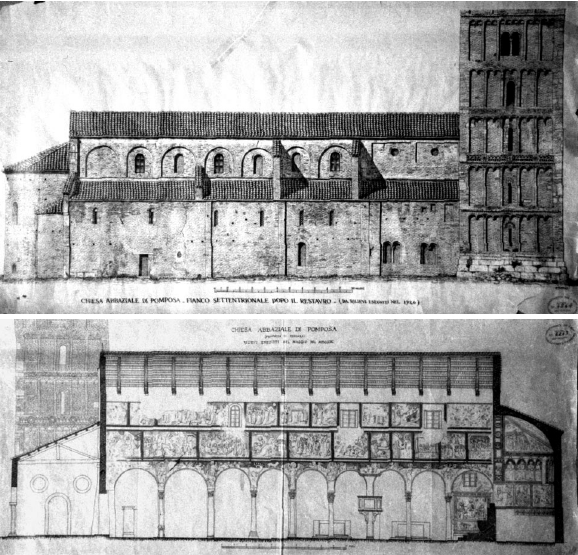
Figure 2. Lateral view of the church and vertical section of the main nave which were drawn in 1926 (data source: Archivio Disegni della S.B.A.A. of Ravenna).